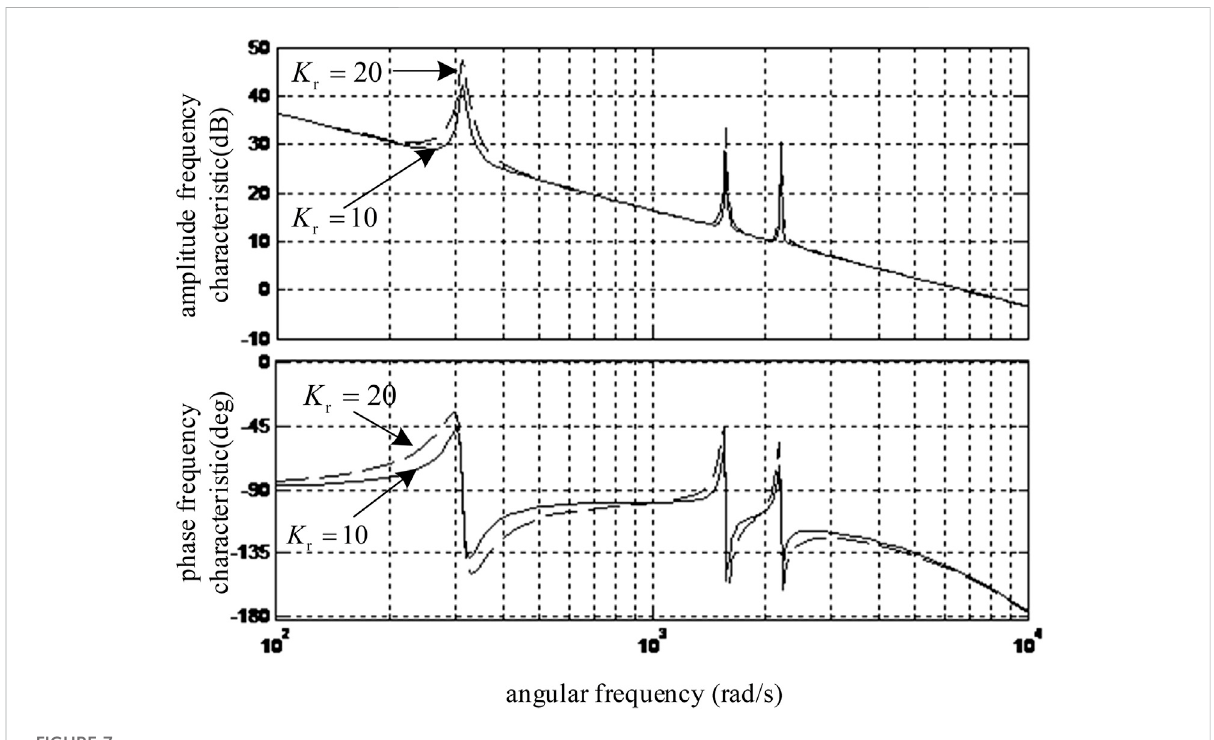
FIGURE 7 The open loop Bode graph of the